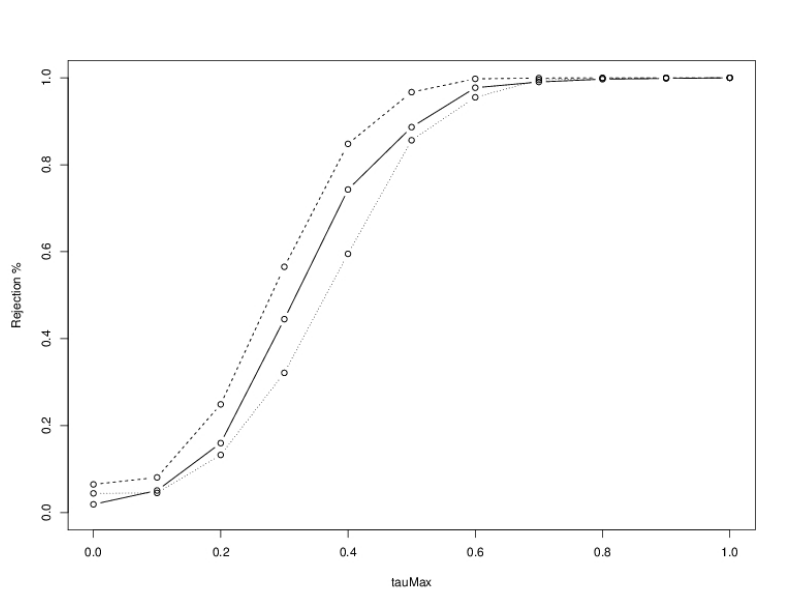
Figure 4: Rejection percentages for the statistics T c 2 (30) as a function of τ max : we use the gaussian copula, with a conditional parameter θ ( x ) calibrated such that the conditional Kendall’s tau τ ( x ) satisfies τ ( x ) = τ max · (cid:98) mΦ ( X 3 ) (cid:99) / m . Solid line: bootNP. Dashed line : bootPI. Dotted line : bootPC.